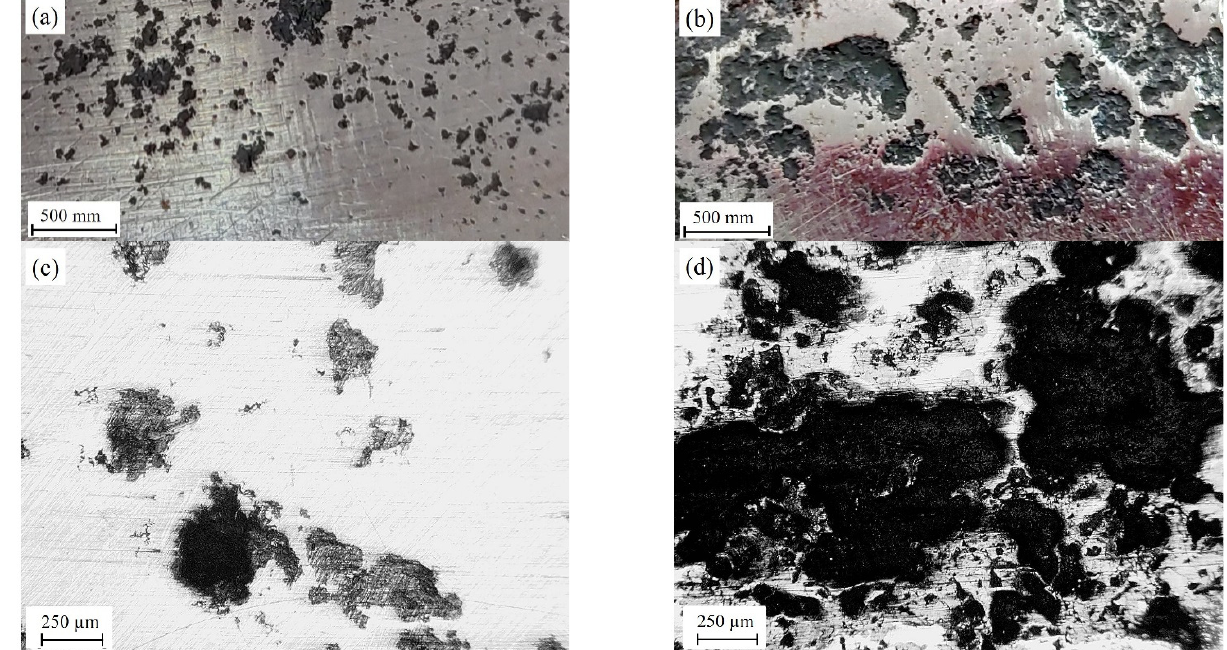
Figure 6. Corrosive damage to the inner surface of the LTO pipe corresponding to ( a , c ) the upper part of the pipe and ( b , d ) its lower part. Table 2. Characteristics of strength ( σ UTS and σ YS ), plasticity ( elongation at break ), and impact tough- ness ( KCV ) of the 17H1S main gas pipeline steel in the AR state and after LTO for 31